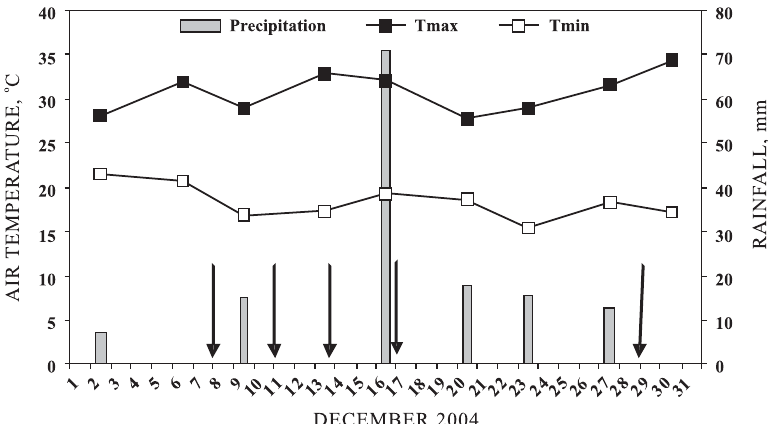
Figure 1. Average daily precipitation and maximum and minimum temperature observed during the gas sampling period (December 2004). Vertical arrows indicate gas collections, on December 8, 2004 = time 0; December 11, 2004 = time 3 days after application (DAA) of SS and fertilizers; December 14, 2004 = 6 DAA; December 17, 2004 = 9 DAA and December 29, 2004 = 21 DAA.